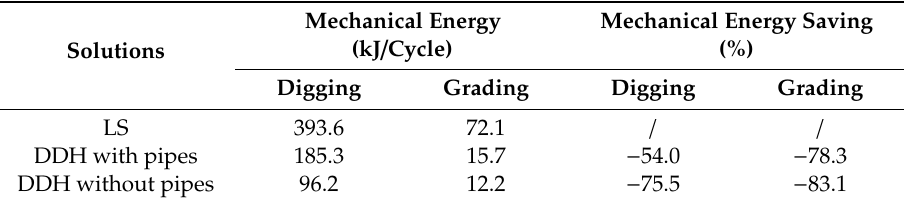
Table 3. Mechanical energy supplied to the pumps.